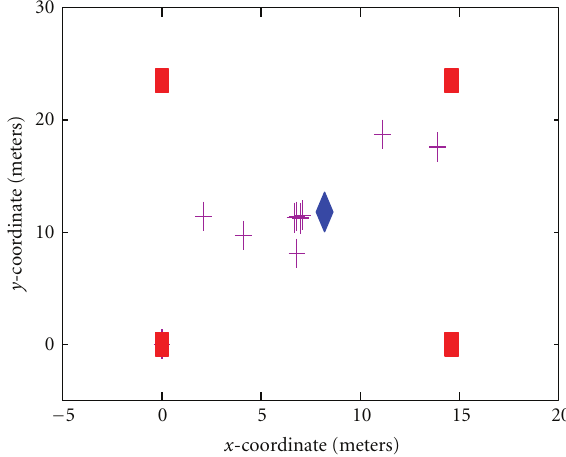
Figure 9: Node deployment during March 2010 pool test. The transmitters are denoted by squares, and the receiver is denoted by the diamond. The scattered plus signs are the estimates by the exhaustive search